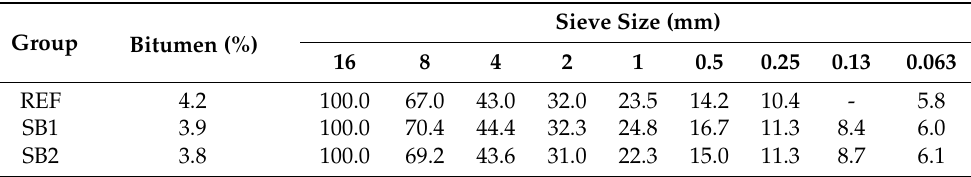
Table 1. Bitumen content and particle size distribution of the aggregates forming the asphalt mixtures